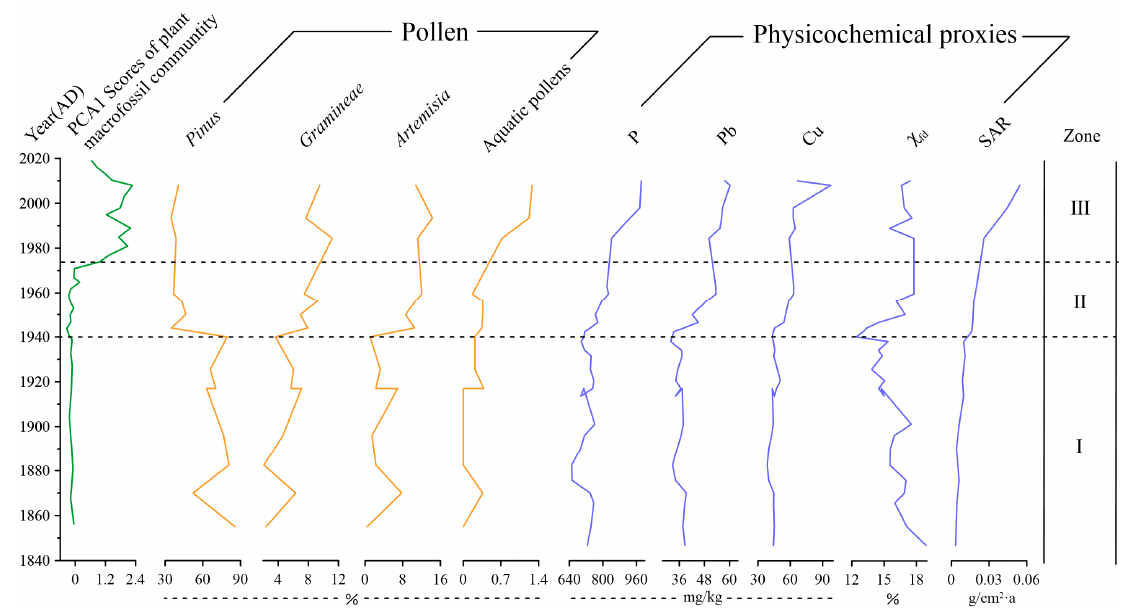
Figure 6. Stratigraphic changes in sedimentary proxies, including pollen, geochemical, magnetic, and sediment rates in the Huanggai Lake. The zonation followed the one revealed by macrofossil records.